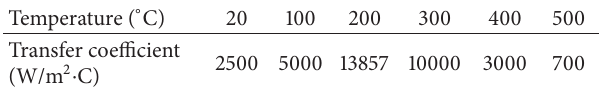
Table 1: Heat transfer coefficient of 7A85 aluminum alloy.